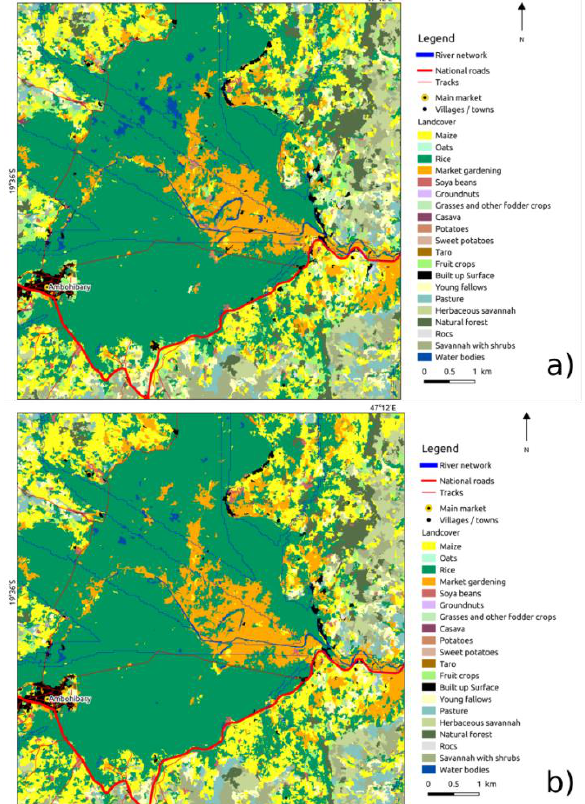
Figure 4. Zoom on land use maps obtained using the remote sensing approach, before (a) and after (b) the redefinition of CMVP values of each entity for which rule-based and remote sensing-based class assignment differs for main